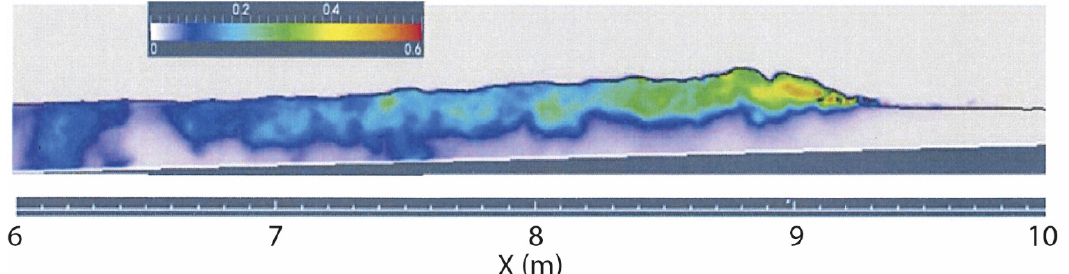
Figure 4. Two-dimensional image from a large-eddy-simulation of spanwise-averaged turbulent intensity under a spilling breaker. Note the considerable distance between the production of turbulence under the wave crest and its intersection with the seabed under the back slope of the wave. Adapted from Zhou et al. [68] with permission from John Wiley and Sons.